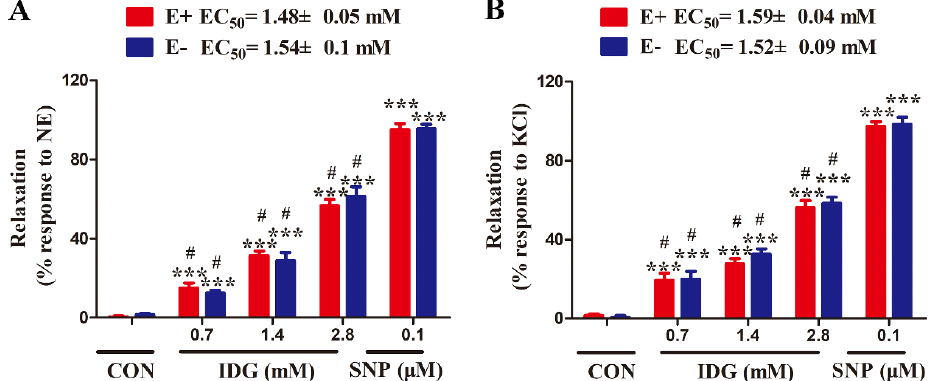
Figure 4. IDG directly caused relaxation in the vascular smooth muscle cells of aorta rings. Figure 4.